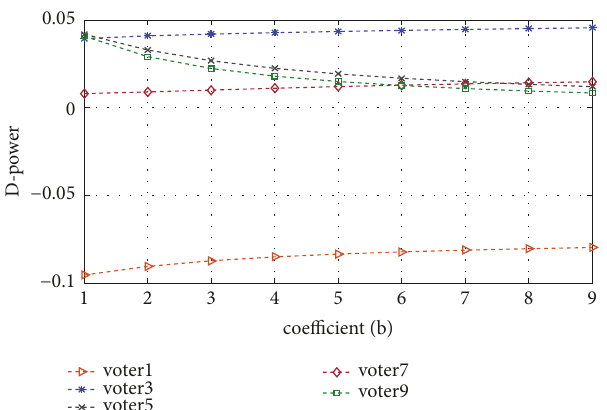
Figure 12: Impact of social learning efficiency on the power index. Voters—within the social network shown in Figure 4—play a repeated voting game with the social learning efficiency parameters 𝑏 rising from 𝑏 = 1 to 𝑏 = 9 while leaving other parameters or conditions